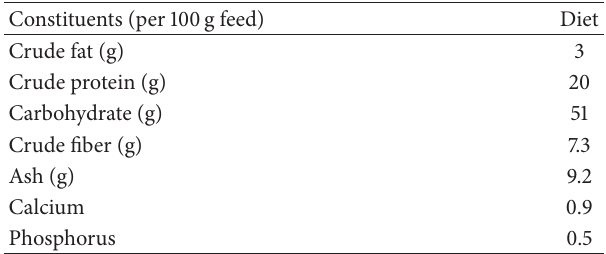
Table 1: Chemical constituents of the standard chow diet (dry- weight